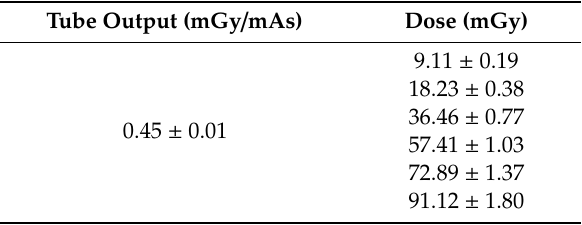
Table 2. Calibration step: X-ray-tube output and dose values.